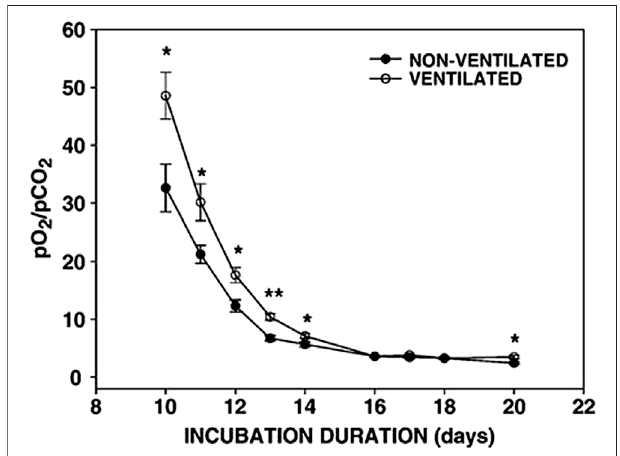
FIGURE 2 | Changes in the ratio of the partial pressure of O 2 and CO 2 in theaircellofthedevelopingegg.* p < 0.05;** p <